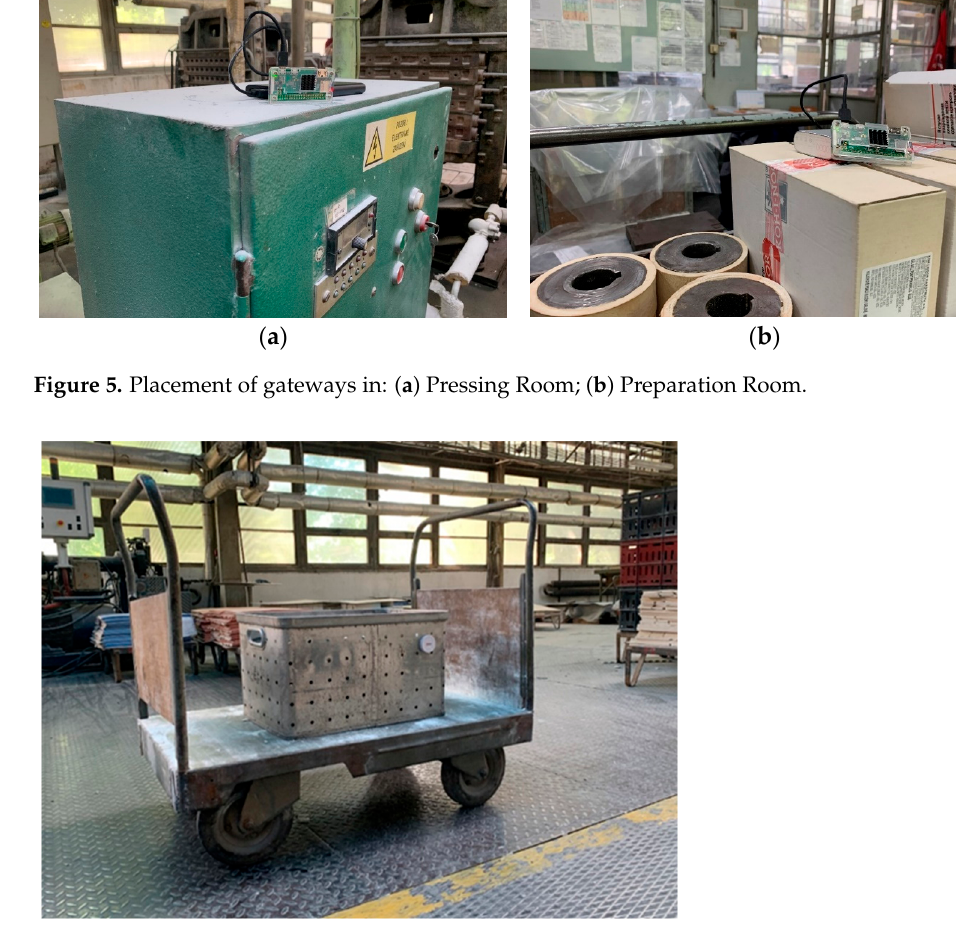
Figure 5. Placement of gateways in: ( a ) Pressing Room; ( b ) Preparation Room.